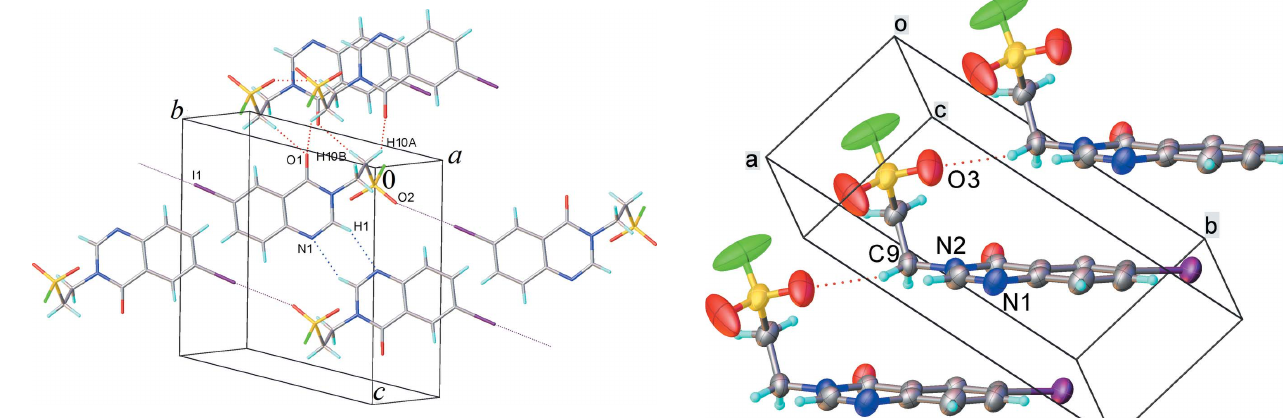
Figure 2 Intermolecular hydrogen (see Table 1) and halogen bonds in the structure of (I).